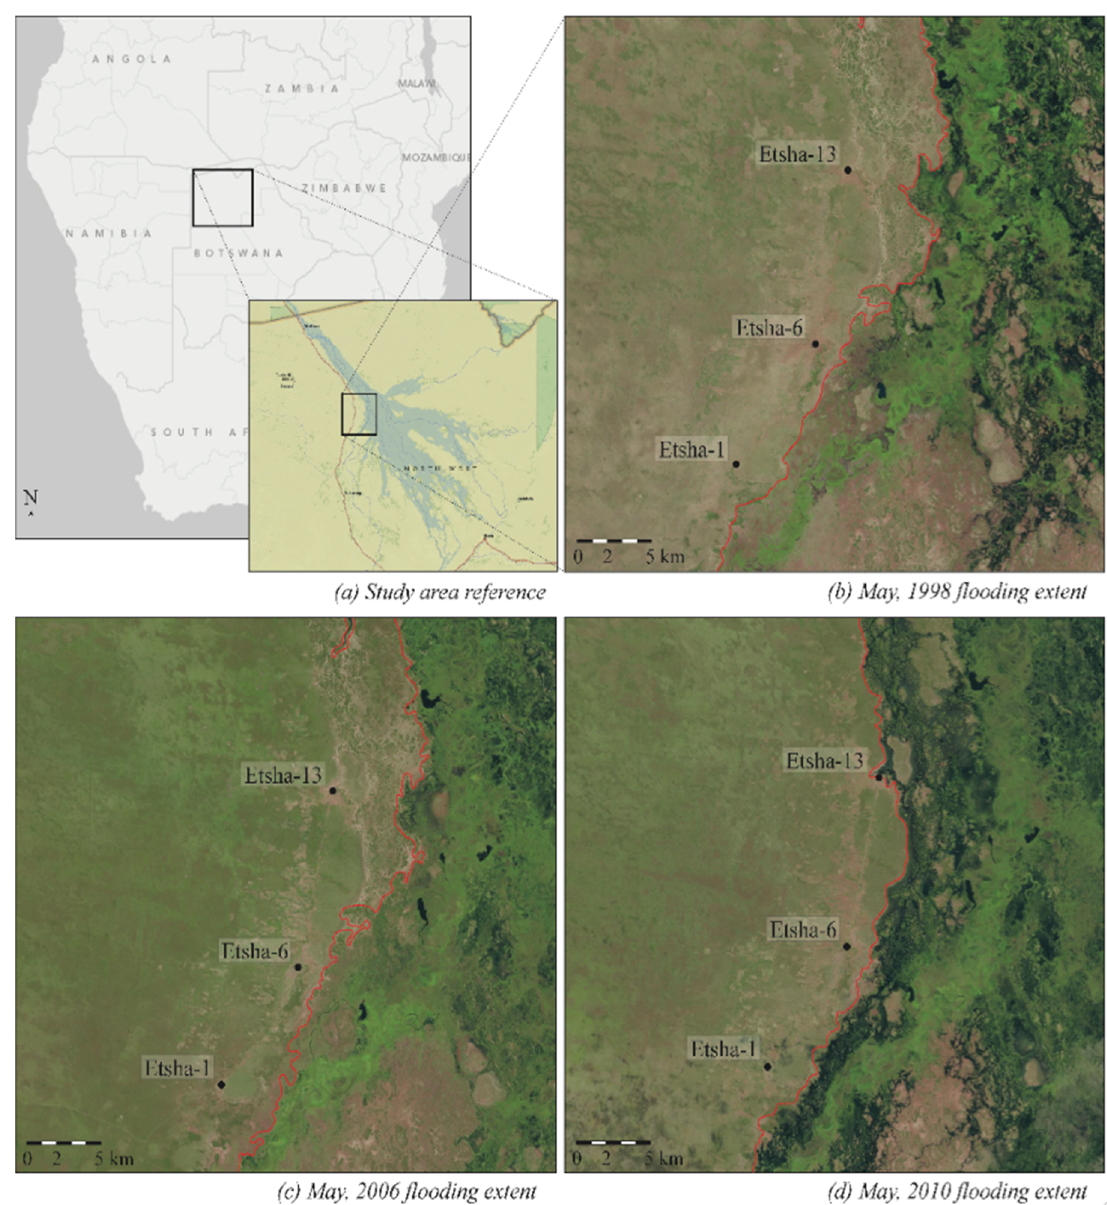
Figure 1. Map of the study region with the variance in the spatial location of flooding indicated by the red line along the edge of the floodwaters. ( a ) Study area reference; ( b ) May, 1998 flooding extent; ( c ) May, 2006 flooding extent; ( d ) May, 2010 flooding extent.